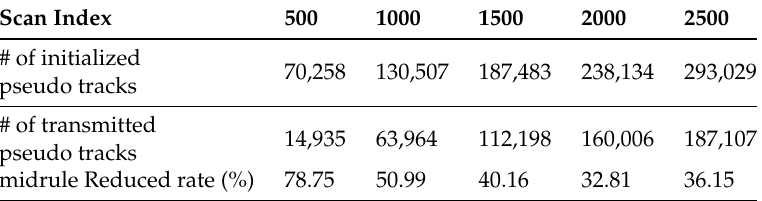
Table 2. Total number of initialized and transmitted pseudo tracks in sonar s 2 at case